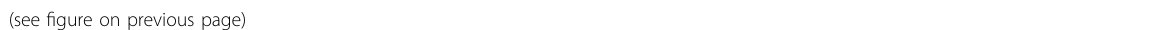
Fig. 1 CHD6 promotes CRC tumorigenesis. a Genomic alterations of CHD6 and other CHD6 family members in the TCGA Colorectal Adenocarcinoma database. b Representative images of IHC staining for CHD6 in human colon cancer and adjacent normal colon tissue (left). A plot showing the relative expression of CHD6 in 76 paired samples of CRC and adjacent normal colon tissue (right). Scale bars, 100 μ m. Data are presented as means ± SD. *** P < 0.001. P values were calculated by two-tailed t -test. c Kaplan – Meier survival curves of overall survival duration based on CHD6 expression in the TMA containing 104 CRC cases. The receiver operating characteristic curve was used to de fi ne the cutoff, and log-rank analysis was used to test for signi fi cance. d Images of subcutaneous tumors derived from HCT116 cells expressing PLKO-Tet-on-sh CHD6 #1, with (sh CHD6 ) or without doxycycline (shCTL) treatment (top). Growth curves of subcutaneous tumors (bottom). Data are presented as means ± SD ( n = 6 per group). * P < 0.05. P value was calculated by two-way ANOVA. e Schematic depiction of generating Chd6 CKO mouse model. f Cartoon illustration of a cross between Chd6 fl / fl and Villin-Cre ERT to breed Chd6 fl / fl ; Villin - Cre ERT ( Chd6 CKO) mice. The Chd6 CKO mice were induced with tamoxifen (TAM) two weeks before AOM/DSS treatment. g Representative images of immuno fl uorescence staining (IF, left), H&E staining (middle), and TEM (right) of colon tissues obtained from the indicated unchallenged mice. Histology score analysis of H&E staining and quanti fi cation of mitochondrial length and cristae number of TEM were shown as bar graph. Data are presented as means ± SD. ns, no signi fi cance, ** P < 0.01. P values were calculated by two - tailed t - test. h Representative images of colons from Chd6 fl / fl + TAM ( n = 6) and Chd6 fl / fl ; Villin - Cre ERT + TAM ( n = 6) mice treated with AOM/DSS. Arrows indicate tumors. i Quanti fi cation of tumor incidence per colon (top) and colon length (bottom) of Chd6 fl / fl + TAM ( n = 6) or Chd6 fl / fl ; Villin- Cre ERT + TAM ( n = 6) mice with AOM/DSS treatme n t. Data are presented as means ± SD. * P < 0.05, ** P < 0.01. P values were calculated by two-tailed t - test. j Representative H&E staining and Ki67 IHC staining on the colon sections obtained from the indicated mice with AOM/DSS treatment (left). Histology score analysis of H&E staining and quanti fi cation of IHC staining were shown as bar graph (right). Data are presented as means ± SD. *** P < 0.001, ** P < 0.01. P values were calculated by two-tailed t